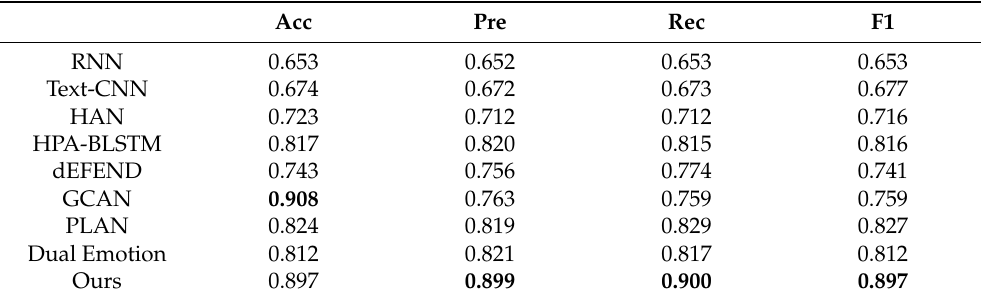
Table 3. Performance comparison between the state-of-the-art models and our model on twitter16. Acc Pre